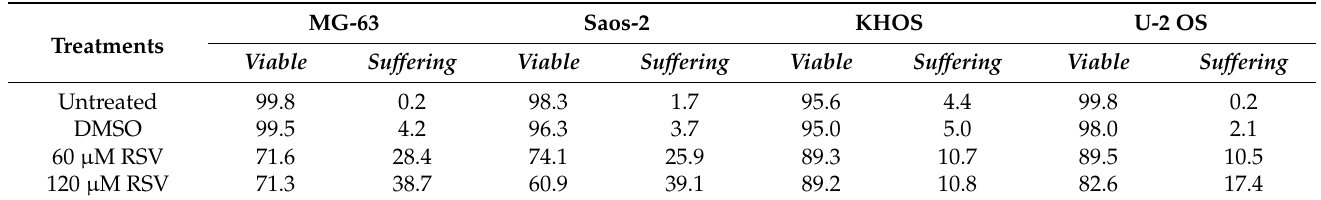
Table 1. The percentages reported summarize the suffering state of the OS cell lines due to RSV treatments. The percentage values of viable cells or unstained cells are given by the percentages reported in the Q3 quadrants of each flow cytometry analysis. The percentage values of the suffering cells are given by the sum of the percentage values of the quadrants Q1 (annexinV positive), Q2 (annexin V/PI positive), Q4 (PI positive) for each cell line.